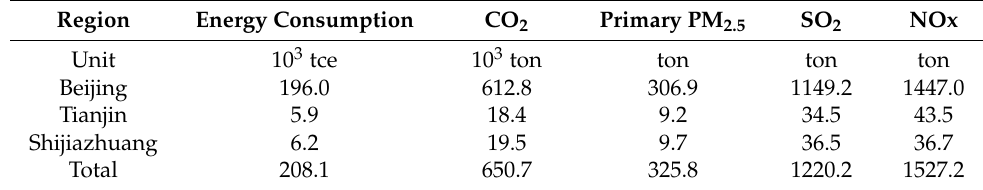
Table 4. Indirect energy saving and emission reduction caused by ridesharing service.